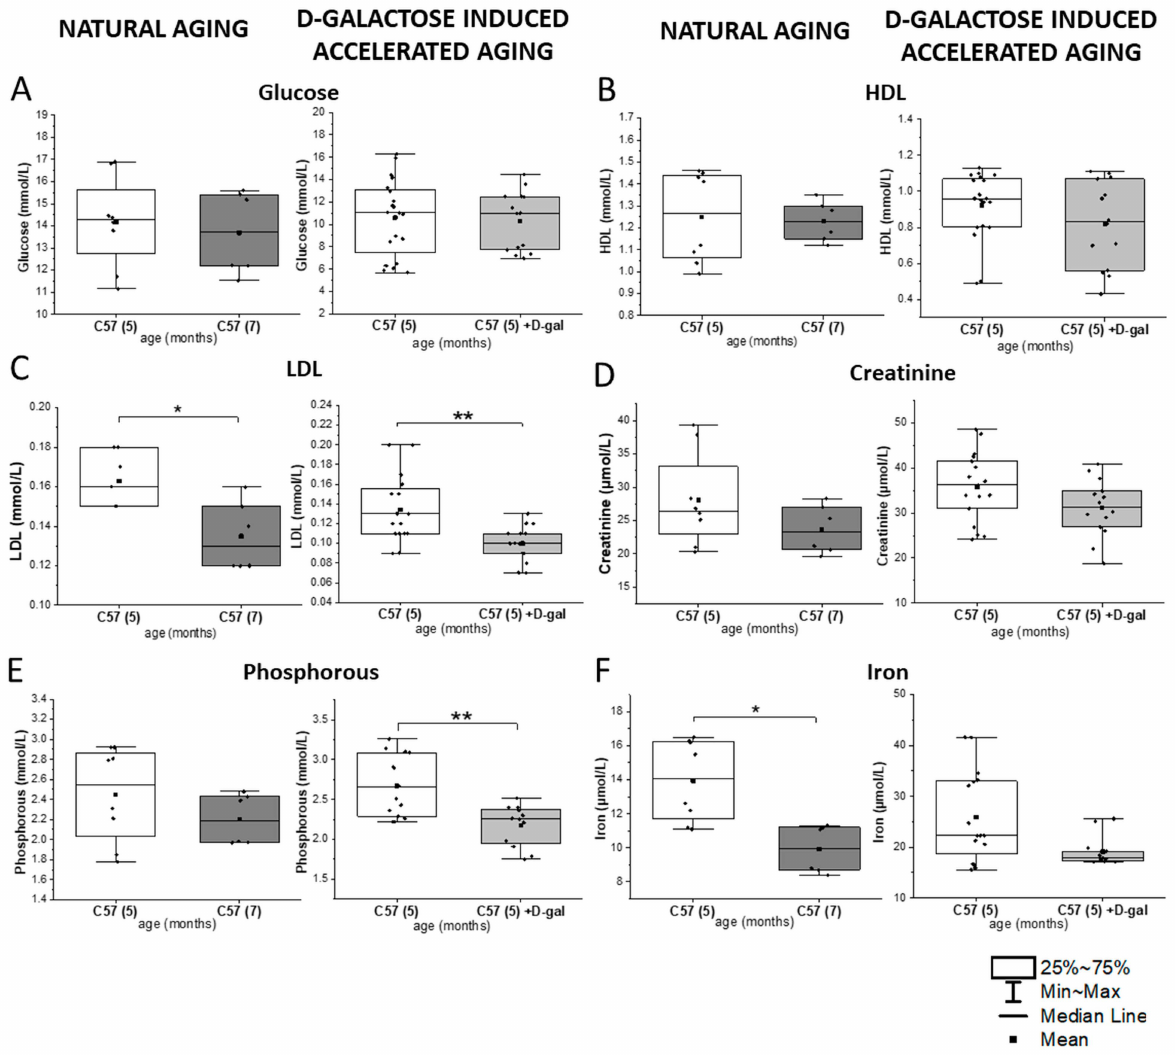
Figure 2. Biochemical parameters in the blood plasma in natural aging and the D-gal model. ( A ) Glucose, ( B ) HDL, ( C ) LDL, ( D ) creatinine, ( E ) phosphorous, and ( F ) iron levels in 5- and 7-month-old male C57BL/6J mice ( n = 4 and n = 3, respectively) in natural aging and 5-month-old male C57BL/6J mice in the D-galactose-induced aging model ( n =7) compared with the control group ( n = 10). The data distribution is presented as boxes (median and interquartile range, min-max whiskers). The statistical significance of the obtained values was tested with a Mann–Whitney test (* p < 0.05; ** p <